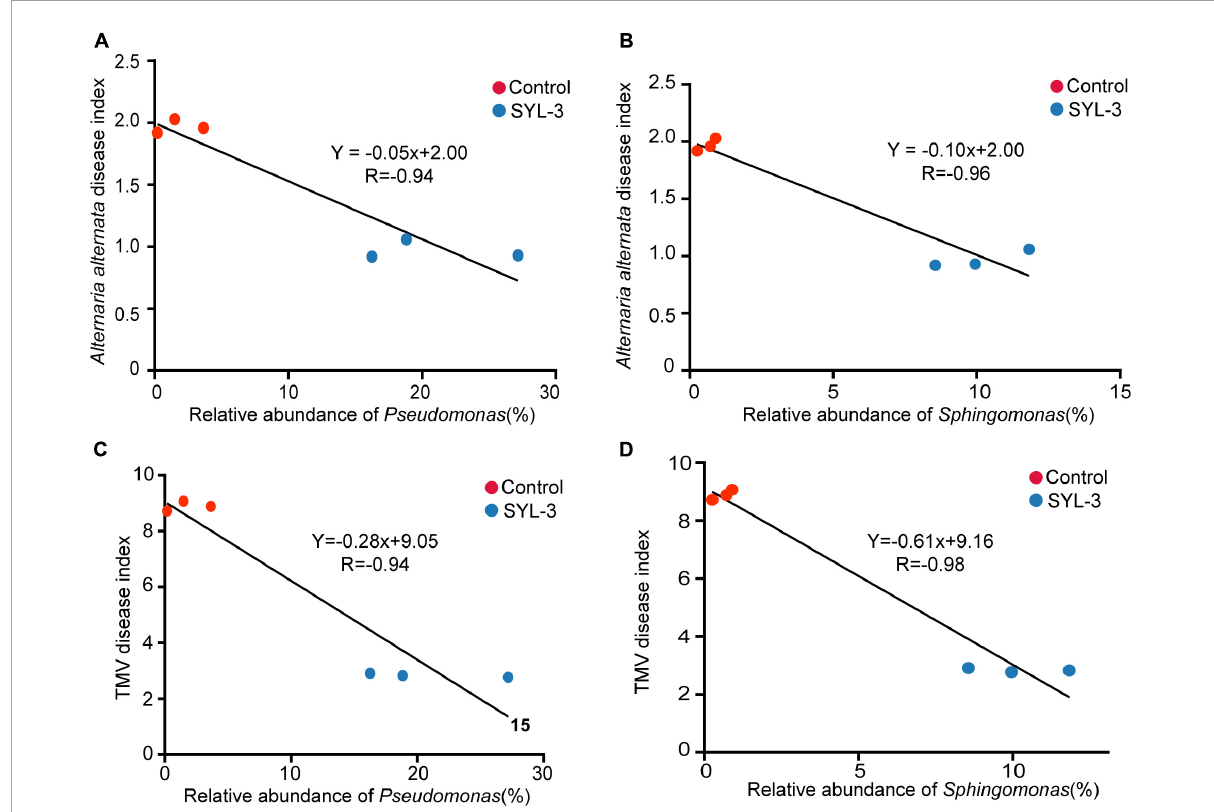
FIGURE7 The correlation between the abundance of Pseudomonas and Sphingomonas and the disease index of A. alternata (A, B) and TMV (C, D)